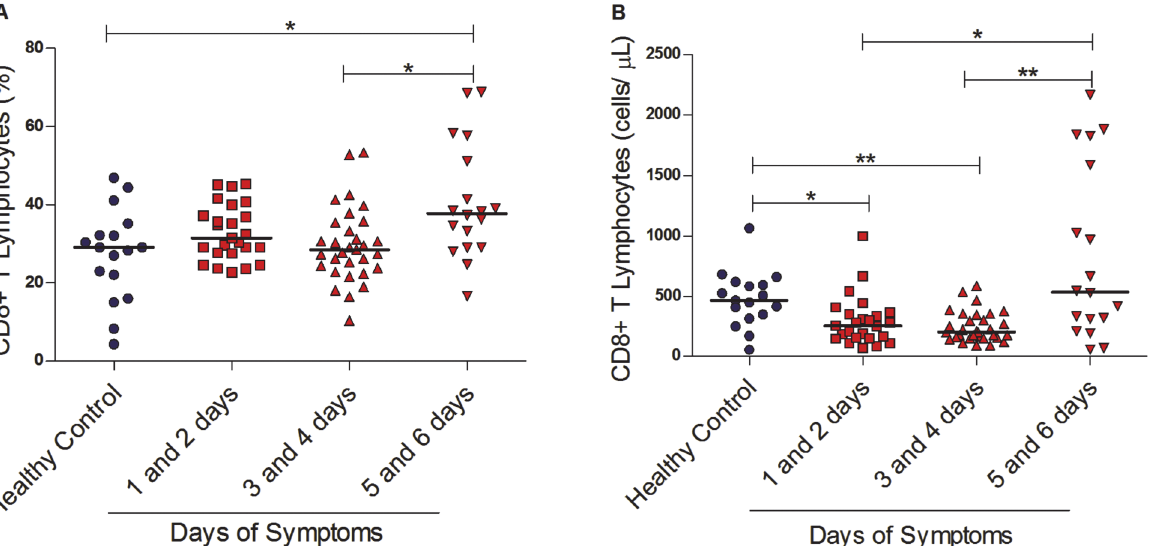
Fig 1. CD8+ T lymphocytes in the course of dengue fever. (A) Percentage within T cells and (B) absolute numbers of CD8+ T lymphocytes in the peripheral blood from healthy controls (n = 17) and dengue fever patients at different days of symptoms (n = 74). A significant change in the percentage of CD8+ T lymphocytes was observed, between days 5 and 6 after the onset of symptoms when compared to healthy controls and days 3 and 4 of symptoms, as shown in A. However, decreased absolute CD8+ T lymphocyte numbers were documented in the first four days of symptoms when compared to healthy controls, returning to higher levels later in the disease ’ s course, as shown in B. * p < 0.05, ** p <